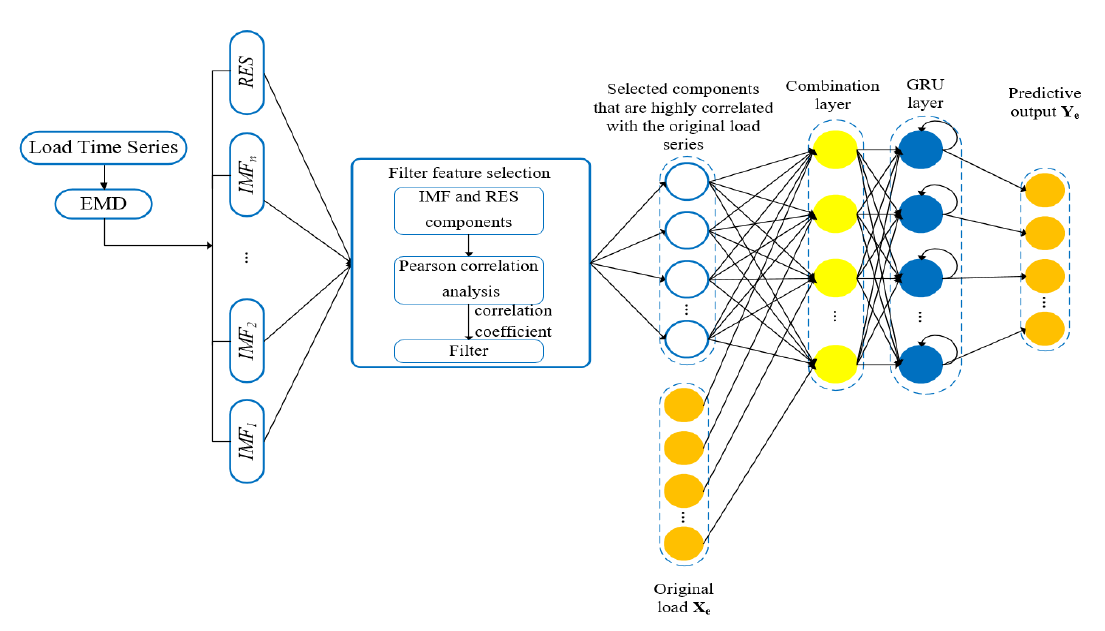
Figure 3. Structure of the proposed empirical mode decomposition-gated recurrent unit (EMD-GRU) model with feature